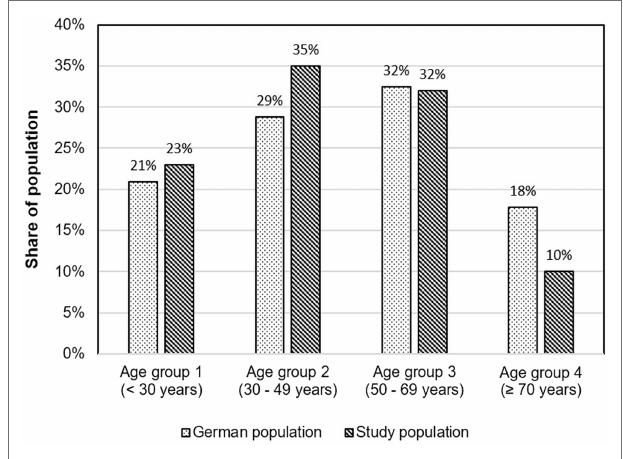
FIGURE 2 | Comparison of the age distribution of the study participants with that of the overall German population.